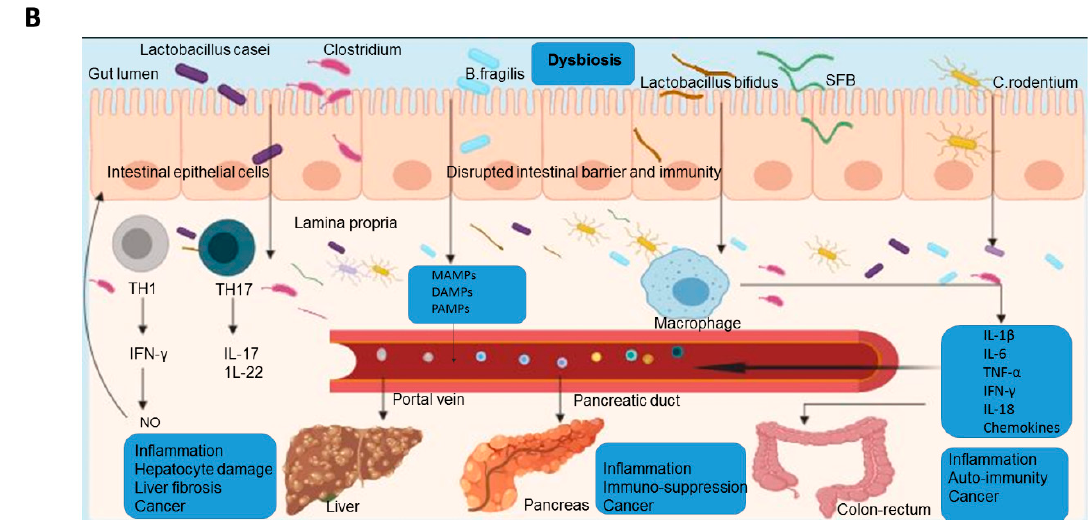
Figure 1. Intestinal homeostasis and dysbiosis of gut microbiomes in gastrointestinal cancer development. ( A ) Gut homeostasis. The gut homeostasis is maintained by an intricate network of factors such as regenerating islet-derived III-gamma (RegIII γ ), interleukin-22 (IL-22) and interleukin-17 (IL-17) secreted by innate lymphoid cells (ILC). These factors regulate the diverse gut microbiome, aid tissue repair, and barrier protection. Inhibition of immune activation by regulatory T cells (Treg) is aided by interleukin-10 (IL-10), retinoic acid and granulocyte macrophage-colony stimulating factor (GM-CSF) secreted by macrophage and innate lymphoid cells (ILC) respectively. In addition, secreted TGF- β and IL-18 preserve the intestinal barrier integrity and also promotes early development of regulatory T cells (Tregs). ( B ) Dysbiosis. On the other hand, an altered gut barrier due to a dysregulated microbiome disrupts the intestinal barrier resulting to leakage of microorganism associated molecular patterns (MAMPs), pathogens associated molecular patterns (PAMPs) and death associated molecular patterns (DAMPs) into the lamina propria. In addition, T helper-1 and T helper-17 produce interferon-gamma (IFN- γ ), interleukin-17 (IL-17), interleukin -22 (IL-22) and excess nitric oxide, which induce loss of barrier integrity. Macrophages secretes inflammatory factors such as tumor necrosis factor (TNF- α ), interferon- gamma (IFN- γ ), interleukin-1 beta (IL-1 β ), interleukin -6 (IL-6), interleukin -16 (IL-16), interleukin-17 (IL-17), interleukin-18 (IL-18), and chemokines. These factors translocate via the portal vein and pancreatic duct to the liver and pancreas, respectively, and do so directly unto the colon–rectum, thereby initiating inflammation and cancer.